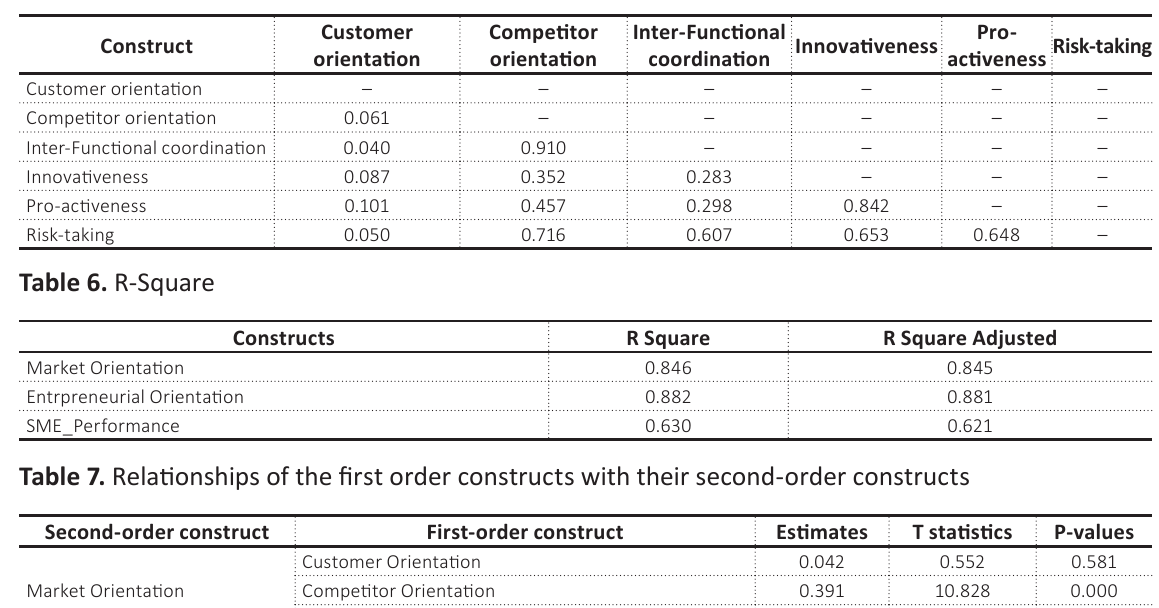
Table 5. Heterotrait-Monotrait (HTMT) ratios